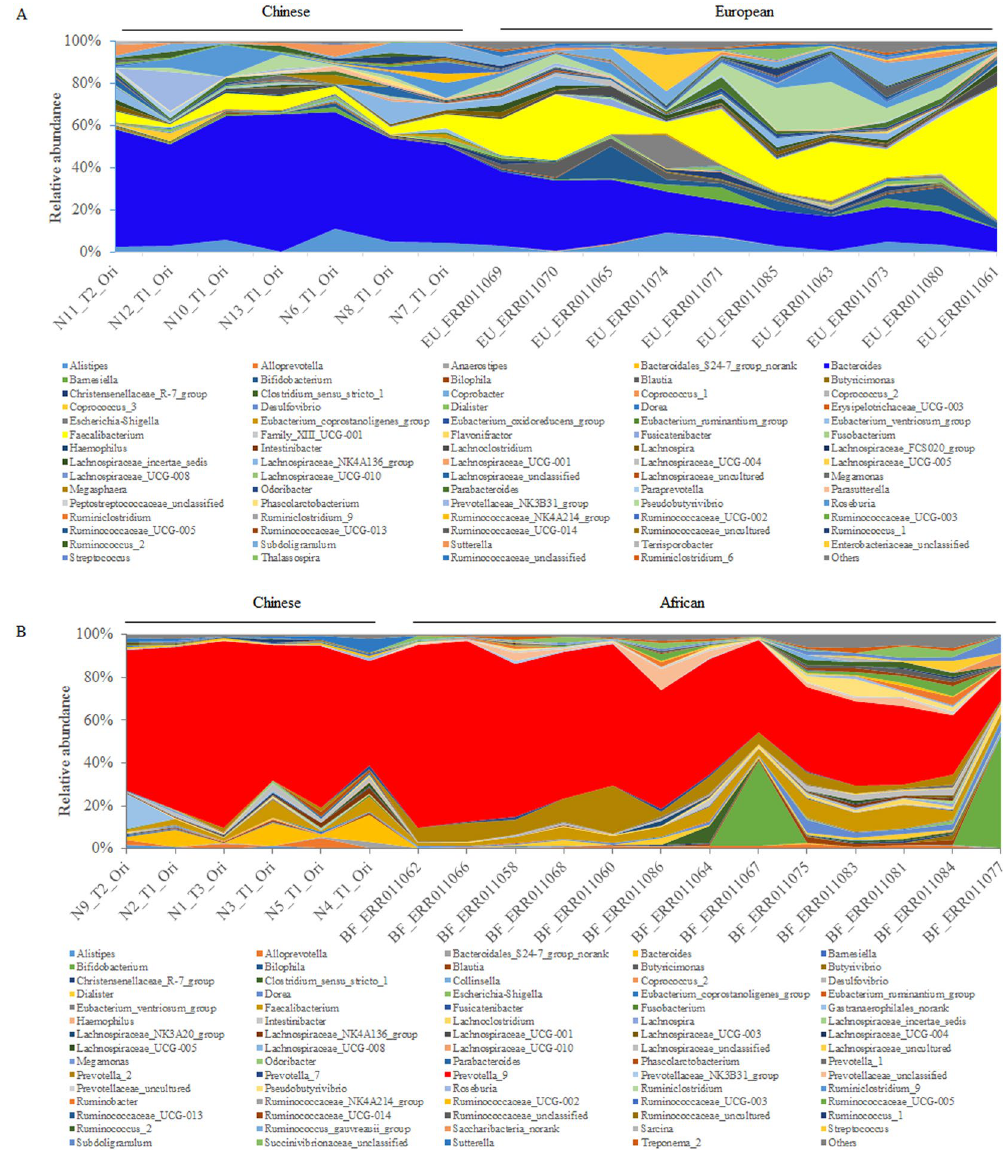
Figure 1. A comparison of the Chinese bacterial community to the European and African communities. Seven Bacteroides and six Prevotella enterotypes were used in this analysis of Chinese bacterial 16S rRNA gene sequencing data. For European and African bacterial 16 S rRNA gene sequencing data, ten Bacteroides and 13 Prevotella enterotypes were downloaded from http://www.ebi.ac.uk/ena/data/view/ERP000133. ( A ) Bacterial community of Bacteroides enterotype in Chinese and European people. ( B ) Bacterial community of Prevotella enterotype in Chinese and African